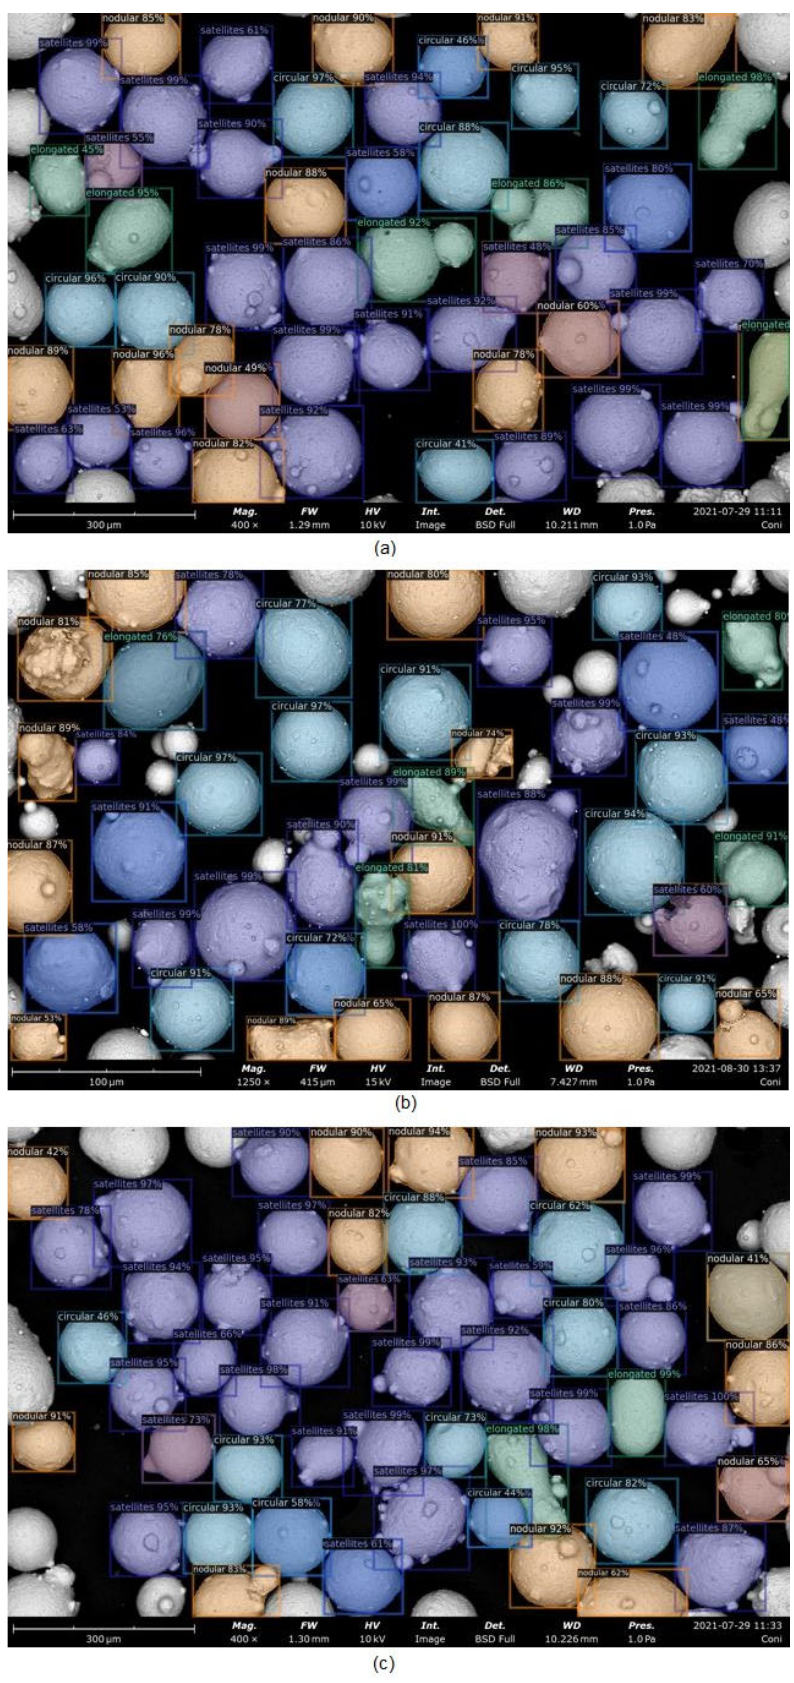
Figure 8. ( a – c ) The model predictions on a batch of backscattered electron images.